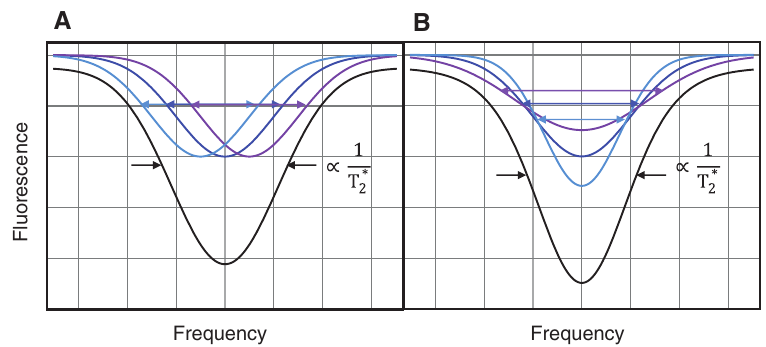
Figure 9: Mechanisms for ensemble broadening. Different colors represent resonance features from different NV sub-ensembles that contribute to the measured resonance linewidth from the entire NV ensemble. (A) Differences in linewidth center frequency due to variations in local environment, e.g. magnetic field and/or strain gradients, and (B) differences in contrast and linewidth due to dephasing from variations in ∗ From Ref. [48].